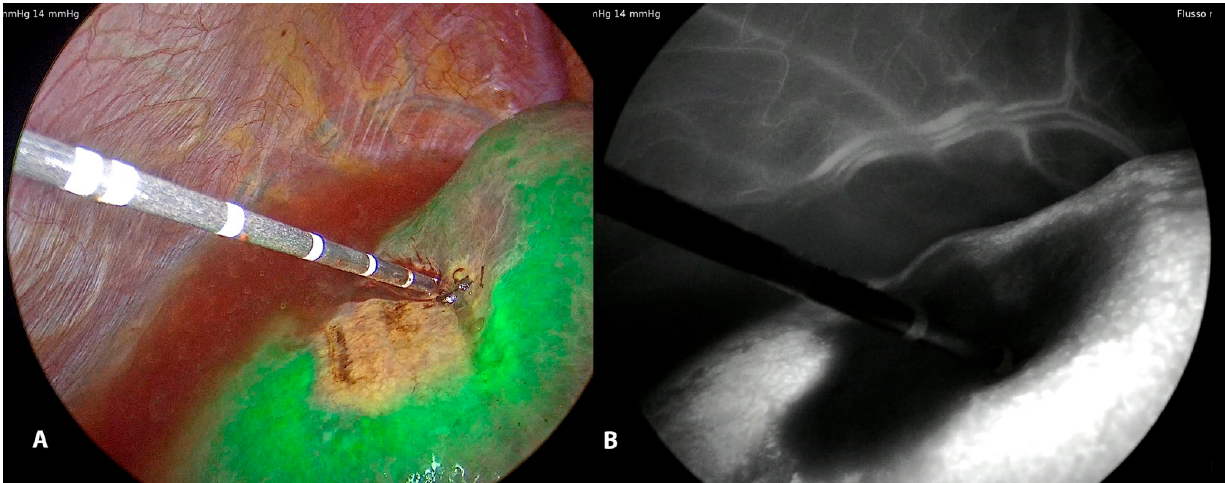
Figure 5. LUS guided puncture to the portal branch feeding the tumor with the fluorescent delineation of vascularized parenchyma ( A ) around the tumor. Monochromatic view ( B ).